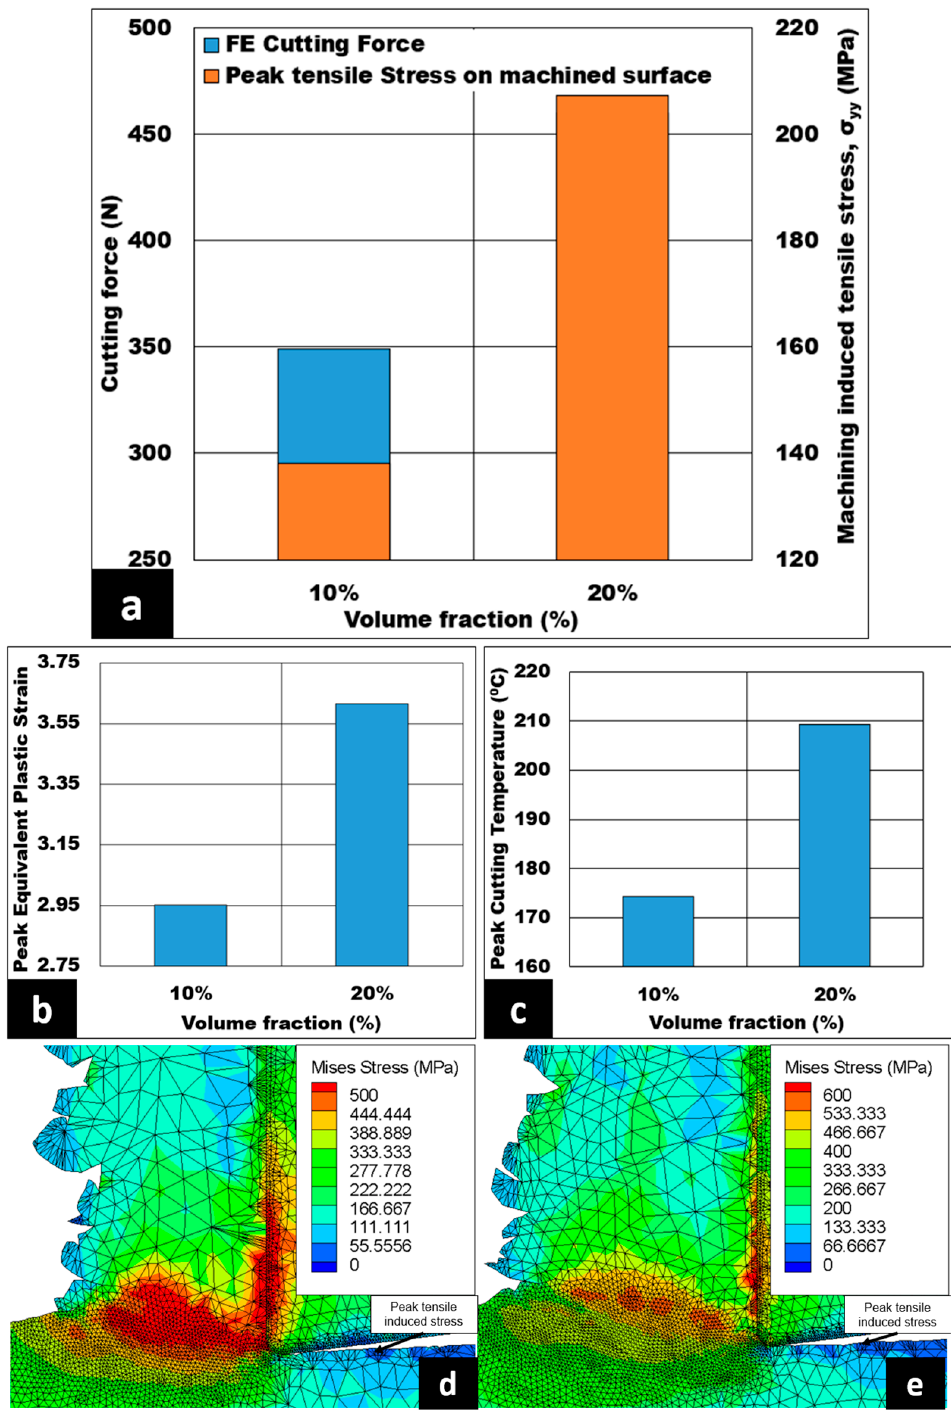
Figure 6. ( a – c ) Effect of volume fraction of alumina bubble present in 7075 on cutting forces, ma- chining induced stress on machined surface, peak equivalent plastic strain, and peak cutting temperature (AdvantEdge TM simulation) (h = 0.07 mm, Vc = 50 m/min, b = 3 mm) under dry conditions; Von Mises stress contour at ( d ) 10% and ( e ) 20%.